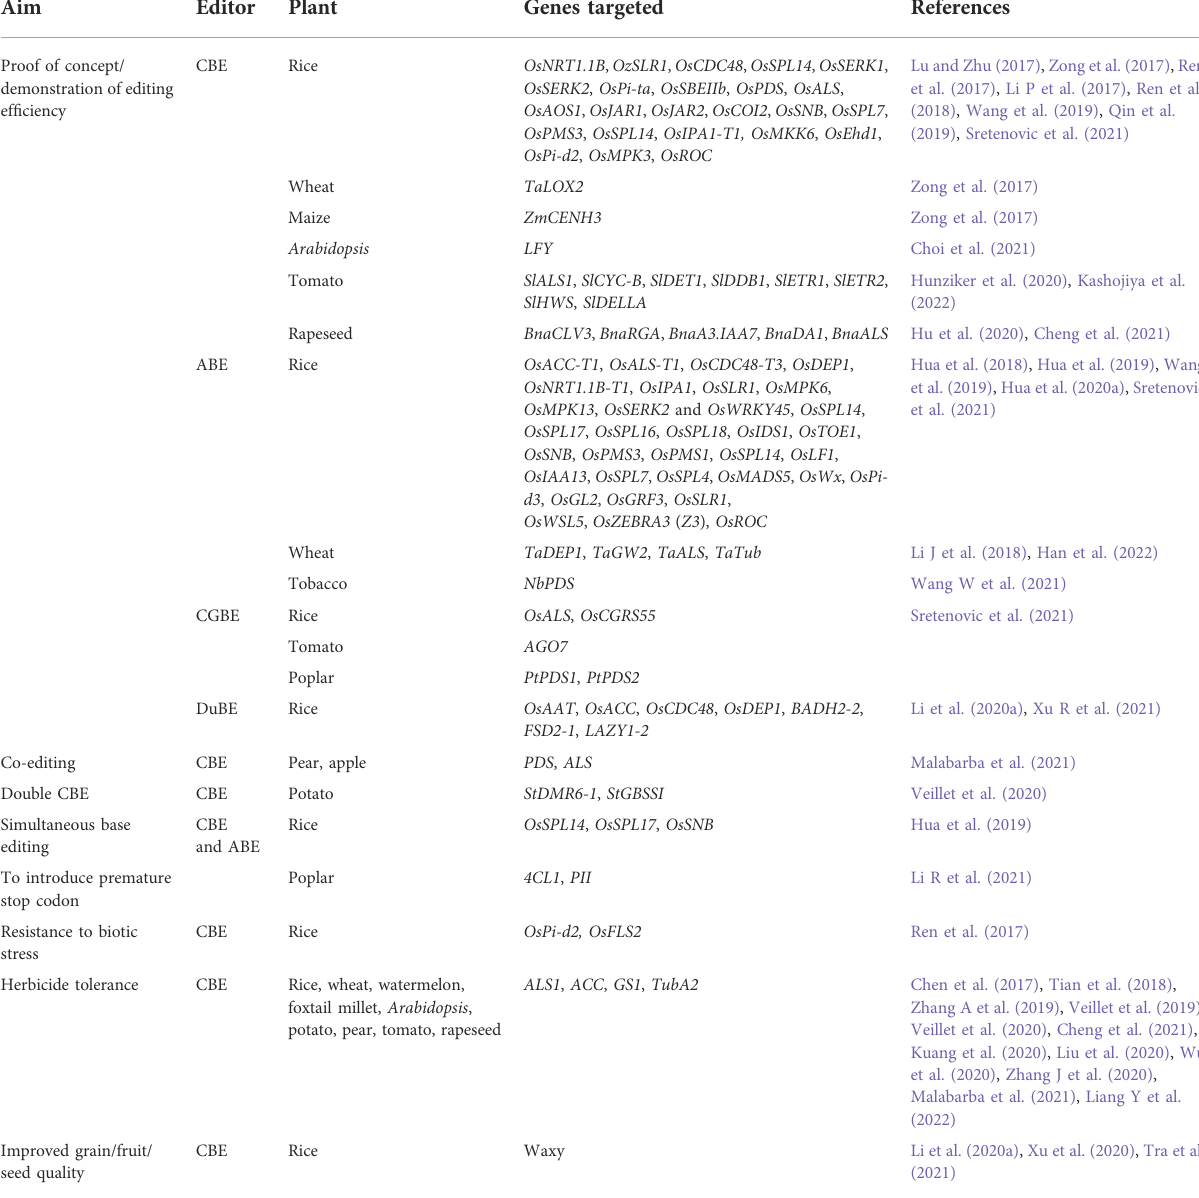
TABLE 4 Base editing mediated proof of concept and improvement studies in major crop